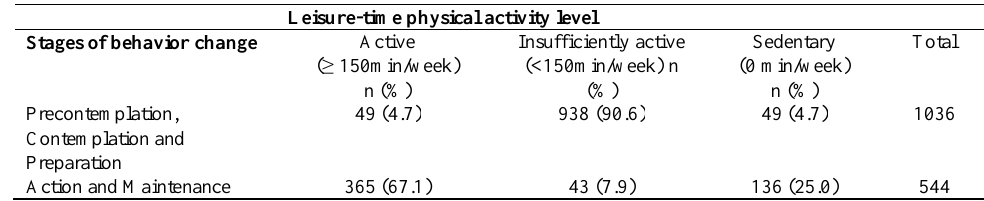
*One participant was excluded from the analysis.